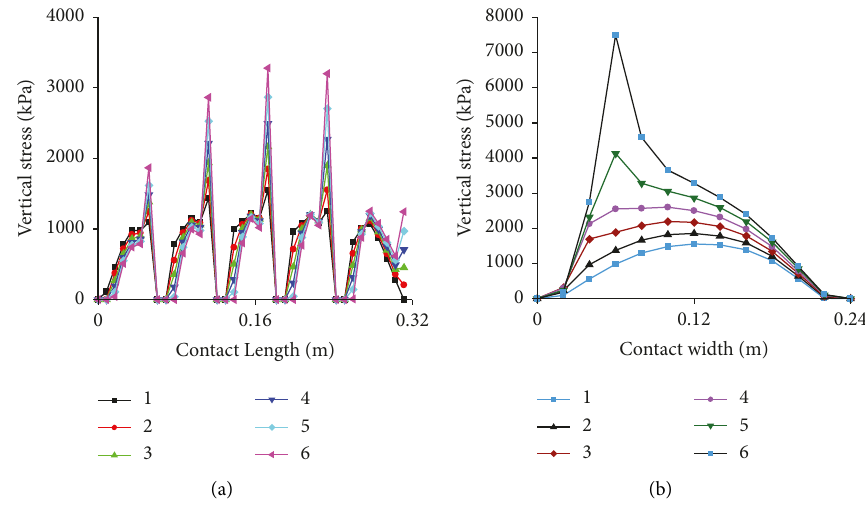
Figure 19: Vertical stress under different slip angles: (a) width and (b) length.